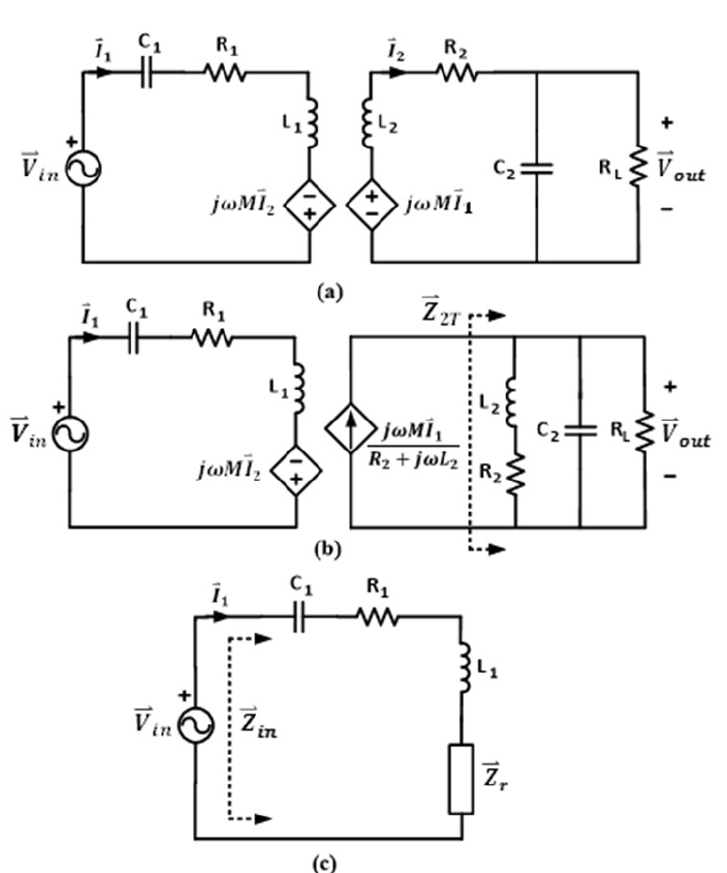
Figure 2. Commonly used model of WPT system: ( a ) Mutual inductance coupling model of the series-parallel (SP) topology WPT system; ( b ) source transformation in the secondary circuit; ( c ) reflected impedance referred to primary circuit.